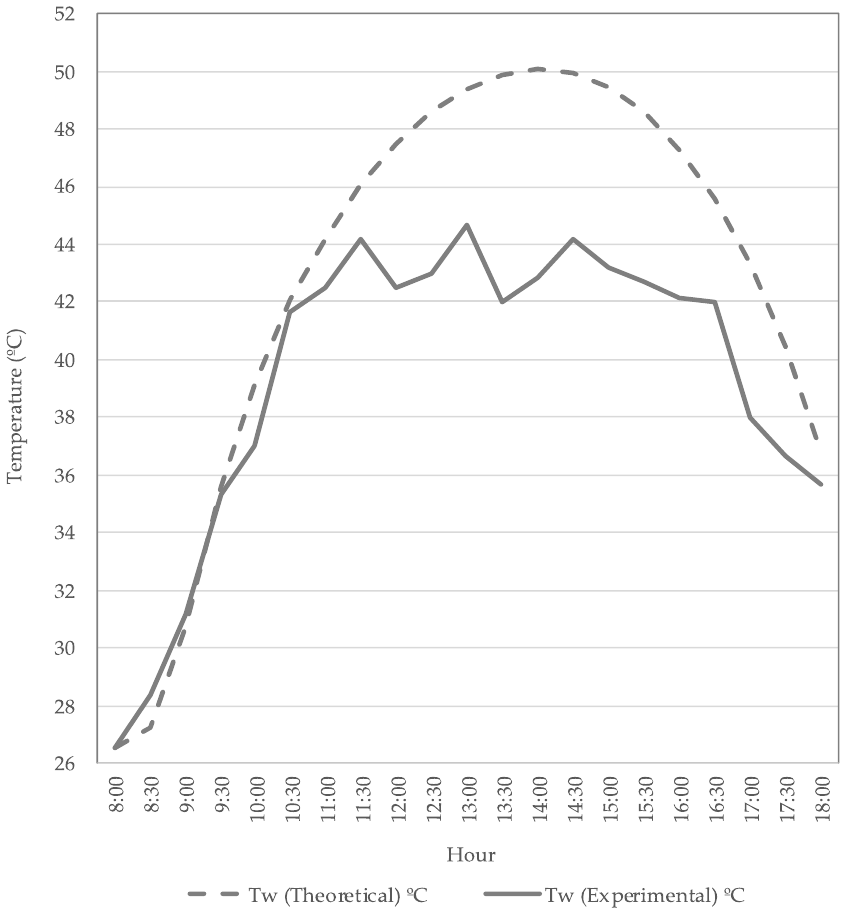
Figure 12. Comparison of experimental and theoretical results. The continuous line represents the average experimental values of water temperature recorded every hour during the monitoring days. The dashed-dotted line represents the theoretical values found with the model proposed by Dunkle.